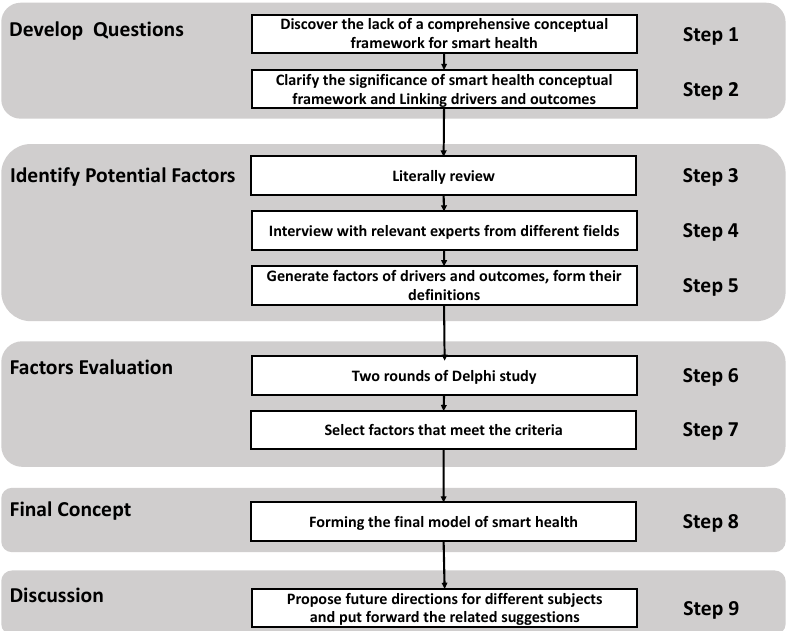
Figure 1. Process of conceptual development of smart health.